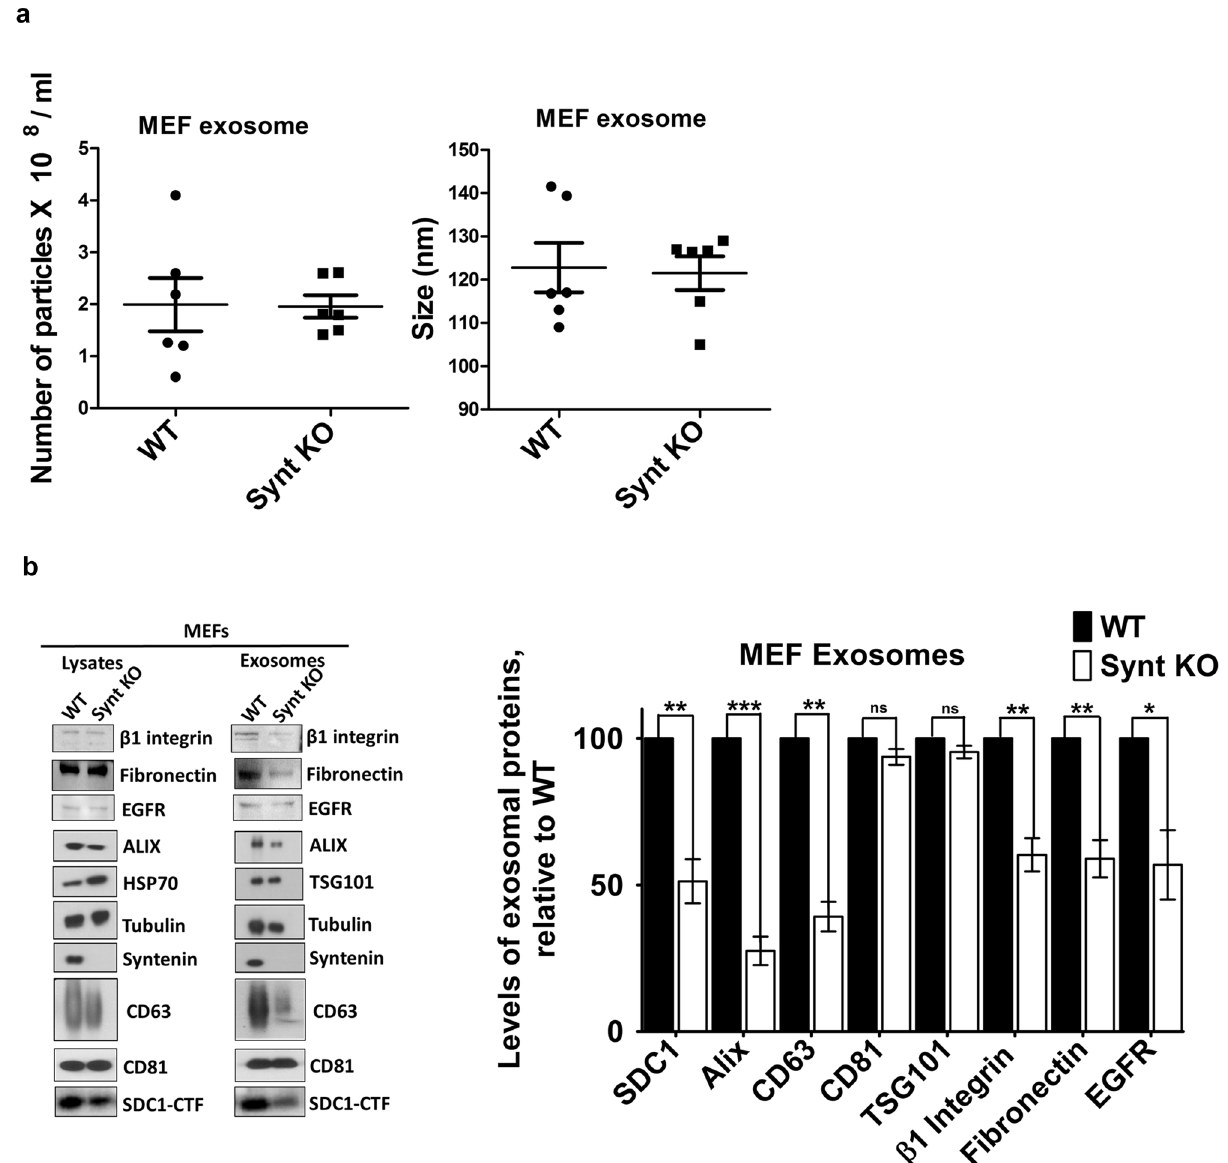
Figure 2. Syntenin-knock out reduces the exosomal secretions of syntenin cargo by primary MEFs in culture. ( a ) Exosome characterization by nanoparticle-tracking. Exosomes were collected from equivalent amounts of culture medium, conditioned by equal numbers of cells, for equal lengths of time. Particle numbers and sizes were analyzed by Nanosight. ( b ) Left: Western blot analysis of proteins present in the lysates and exosome preparations of WT and Synt KO MEFs in primary culture. Exosomes were collected from equivalent amounts of culture medium, conditioned by equal numbers of cells, for equal lengths of time. Right: Bar graphs showing the levels of exosomal marker proteins in Synt-KO MEFs, relative to the levels measured in WT cells (taken as 100%). Note the concurrent decreases of ALIX, CD63 and syndecan 1-CTF (SDC1-CTF), and potential syndecan cargo such as B1-integrin, fibronectin, and EGFR, but not CD81 and TSG101, in the exosomes of Synt KO